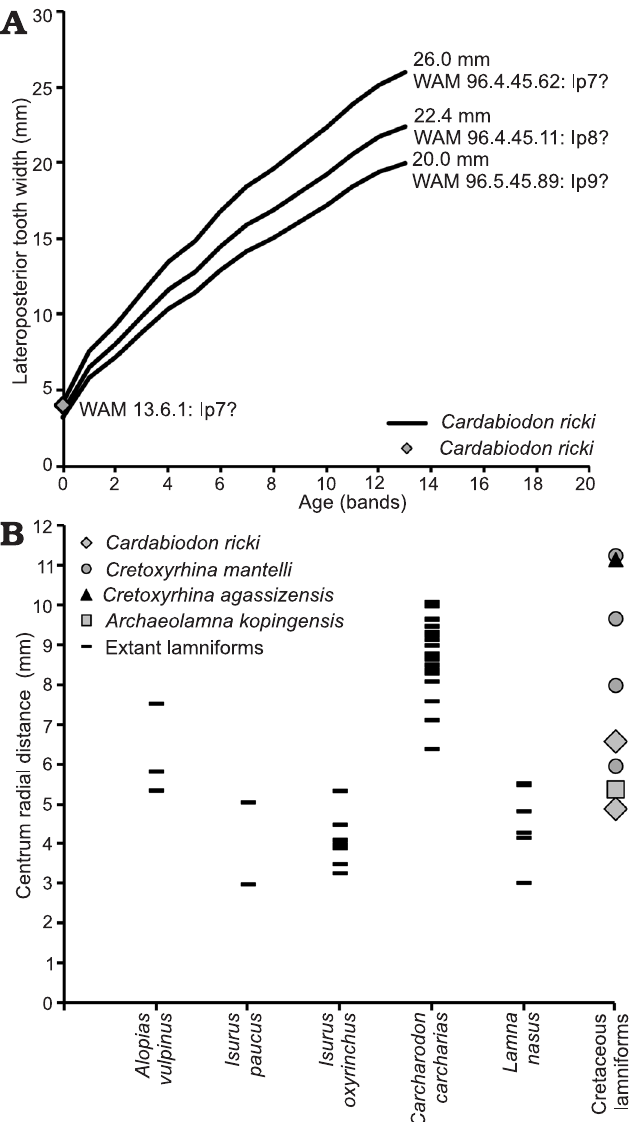
Fig. 11. Comparisons of teeth and centra at approximate neonate ages. A . Dahl-Lea back-calculated growth profiles of tooth width (maximum mesiodistal distance of the root) for lower lateroposterior (lp) teeth (7–9?) of Cardabiodon ricki . B . Birth ring radial distance (measured along a trans- verse plane at the anterior or posterior ends of the centrum) for neonates of six extant species (Cailliet et al. 1985; Compagno 2001) and Cretaceous lamniforms including Cardabiodon ricki , Cretoxyrhina mantelli , Cretoxy- rhina agassizensis , and Archaeolamna kopingensis (large